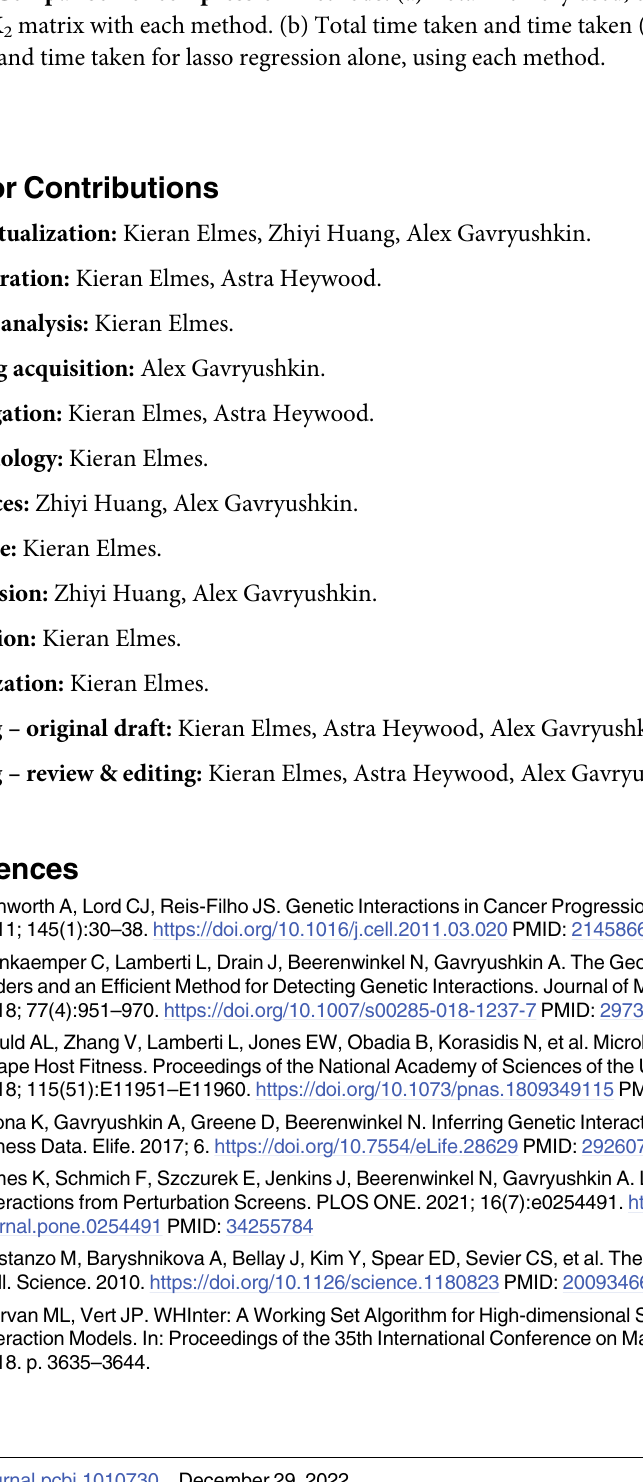
. In both cases n = 10 � p . 2